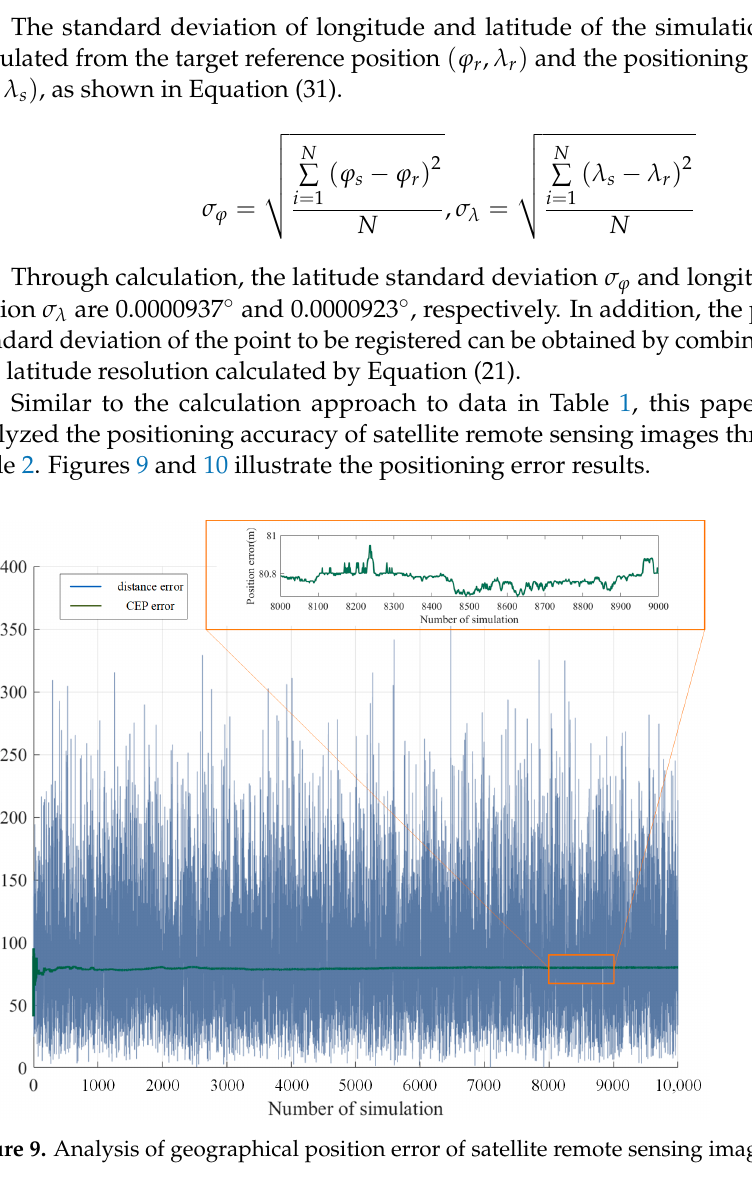
Figure 9. Analysis of geographical position error of satellite remote sensing image.